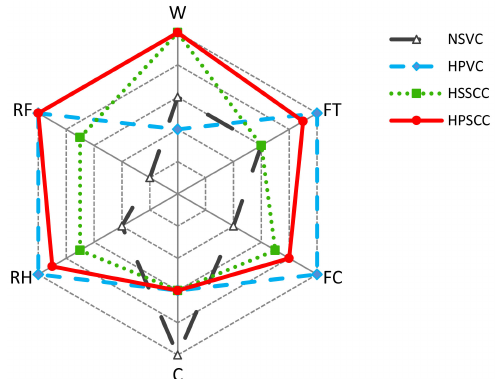
Figure 9. Hexagonal model for multi-parameter comparison of different concrete classes (W—workability measures; FT—tensile strength; FC—compressive strength; C—economic considerations; RH—residual strength after heating to +700 ◦ C; RF—residual strength after 50 cycles of freezing and